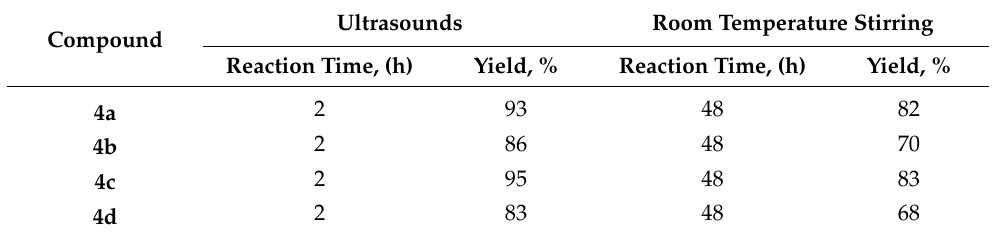
Table 2. The synthesis of corresponding azides under US irradiation and room temperature stirring. Ultrasounds Room Temperature Stirring Compound Reaction Time,